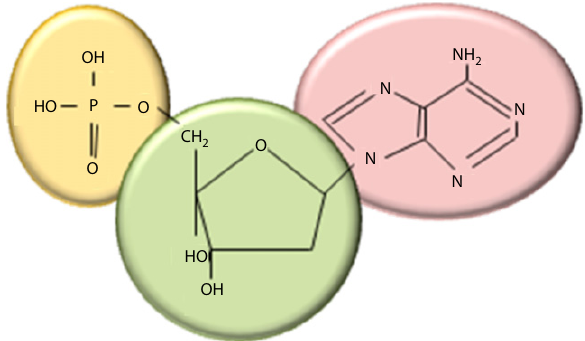
Figure 1. The chemical structure of a nucleotide including the phosphate (yellow), the sugar (deoxyribose in green) and adenine as the nitrogenous base (pink). The DNA structure is a double helix, in which two DNA molecules are held together by weak hydrogen bonds [3–7]. Hydrogen bonding occurs between laterally opposed bases, of the two strands according to Watson-Crick rules: A specifically binds to T, and G to C. The two strands are therefore complementary [8]. As the phosphodiester bonds link carbon atoms number 3’ and number 5’ of successive sugar residues, the end of each DNA strand will have a terminal sugar residue where carbon atom number 5 is not linked to a neighboring sugar residue, and is therefore called 5’ end